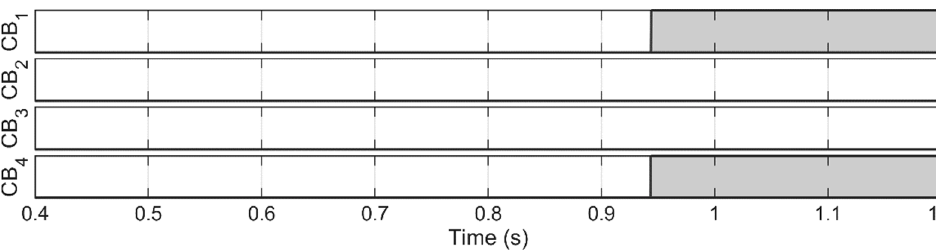
Figure 25. Operation of circuit breakers in case DCR and DOCR fail.